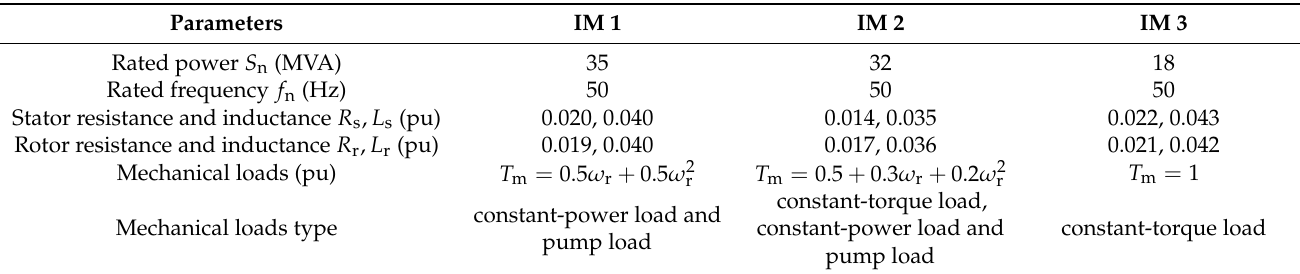
Table A3. The parameters of the induction